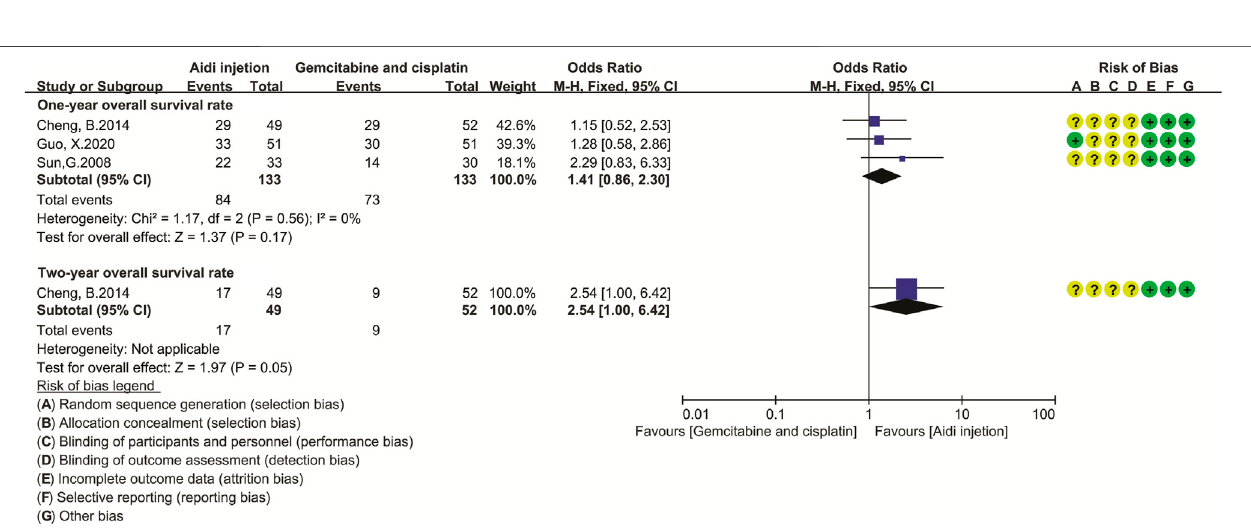
FIGURE5| Theanalysisofoverallsurvivalrate.Theresultshowednodifferenceinone-andtwo-yearOSratebetweenthetwogroups(OR (cid:1) 1.41,95%CI[0.86to 2.30], p (cid:1) 0.17; and OR (cid:1) 2.54, 95% CI [1.00 to 6.42], p (cid:1) 0.05). Note: GP, Gemcitabine and cisplatin.